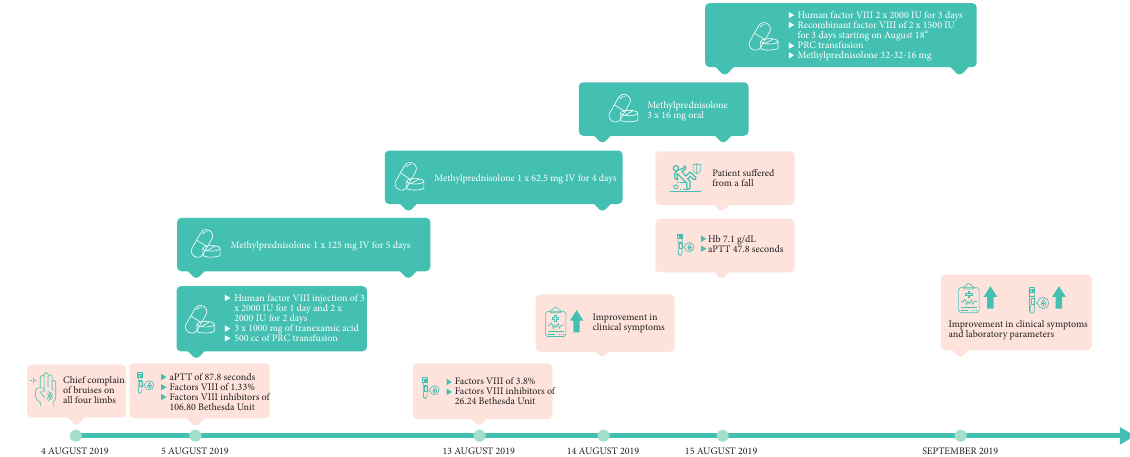
Figure 2: Timeline of events and interventions for case